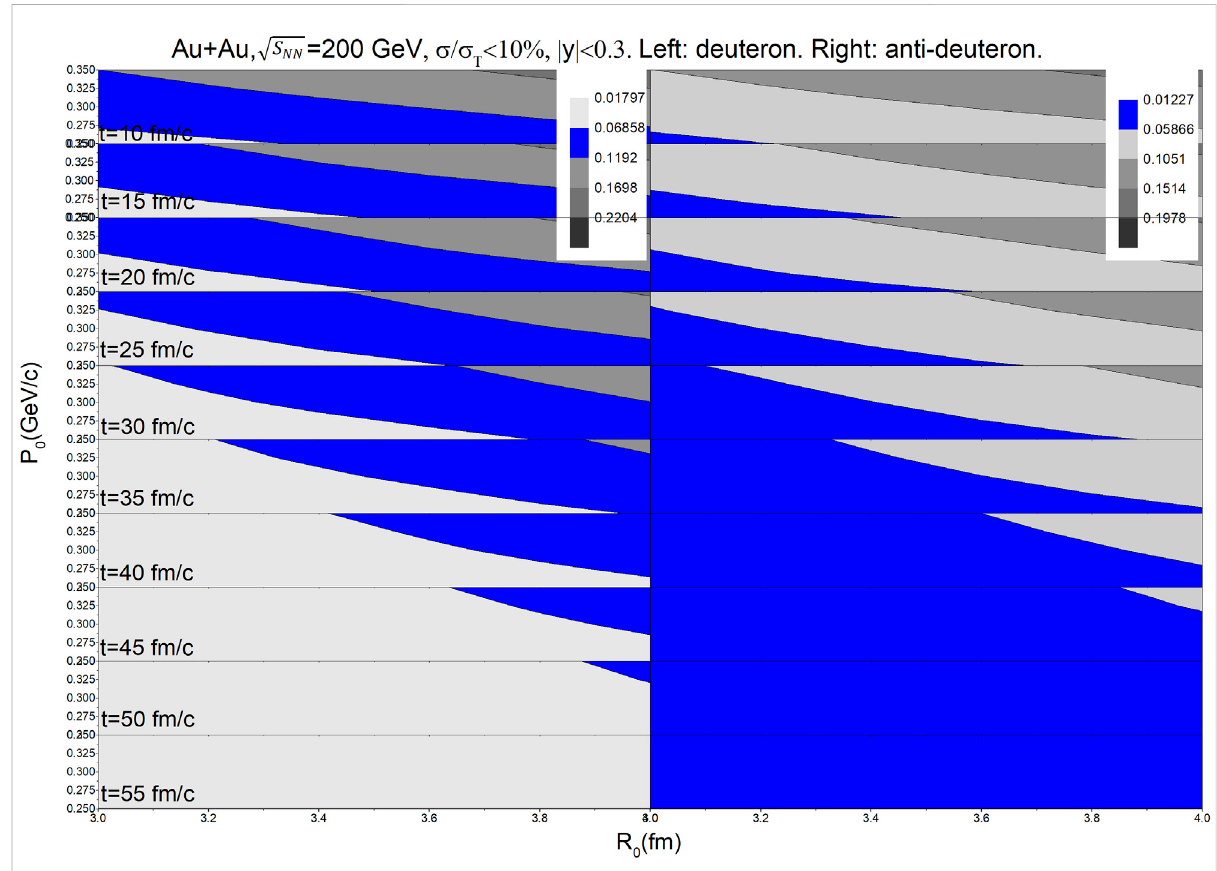
FIGURE 3 Time evolution of R 0 - P 0 contour plots of (anti-)deuteron from the central Au + Au collisions at range of experimental data from the STAR collaboration